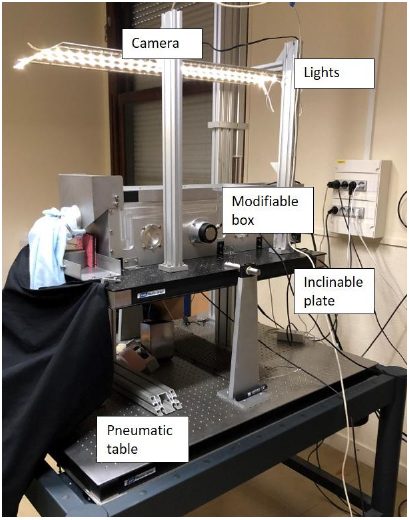
Figure 1. Photography of the experimental